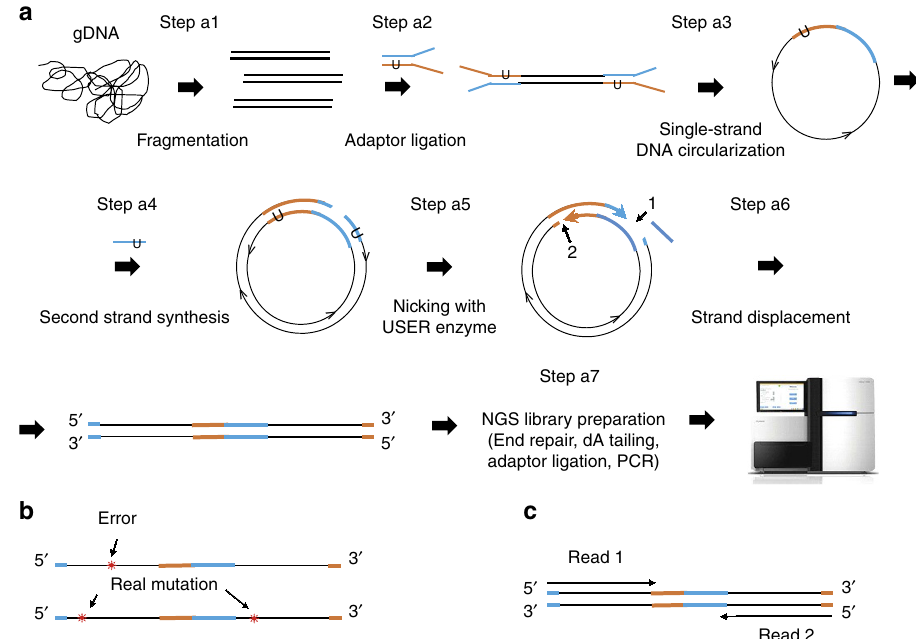
Figure 1 | Overview of o2n-seq. ( a ) O2n-seq workflow. gDNA is sheared into fragments shorter than half the length of the sequencing read (for example, if we sequence reads with PE 125, the length of fragments should shorter than 125bp) and ligated with Y-shaped adaptors (blue and orange lines) with candidate nicking sites (such as dUTP), then denatured into single-stranded DNA molecules that are circularized using single-stranded DNA ligase. After eliminating linear DNA using DNA exonucleases, the circularized single-stranded DNA is employed for second-strand synthesis. Next, the double-stranded circular DNA is nicked with the USER enzyme and subjected to strand displacement amplification. The purified, strand displacement-amplified DNA can be used to prepare a standard NGS library. The arrows represent the direction of DNA (5 0 - 3 0 ). ( b ) Remove errors. If a variant (red star) is support by only one DNA copy, an error must have occurred at the site, and this type of site is discarded in the following data analysis procedure. However, if a variant is supported by both DNA copies, it is treated as a true variation. ( c ) Using a PE sequencing strategy to sequence o2n-seq reads. Read 1 and Read 2 are sequencing reads of one PE